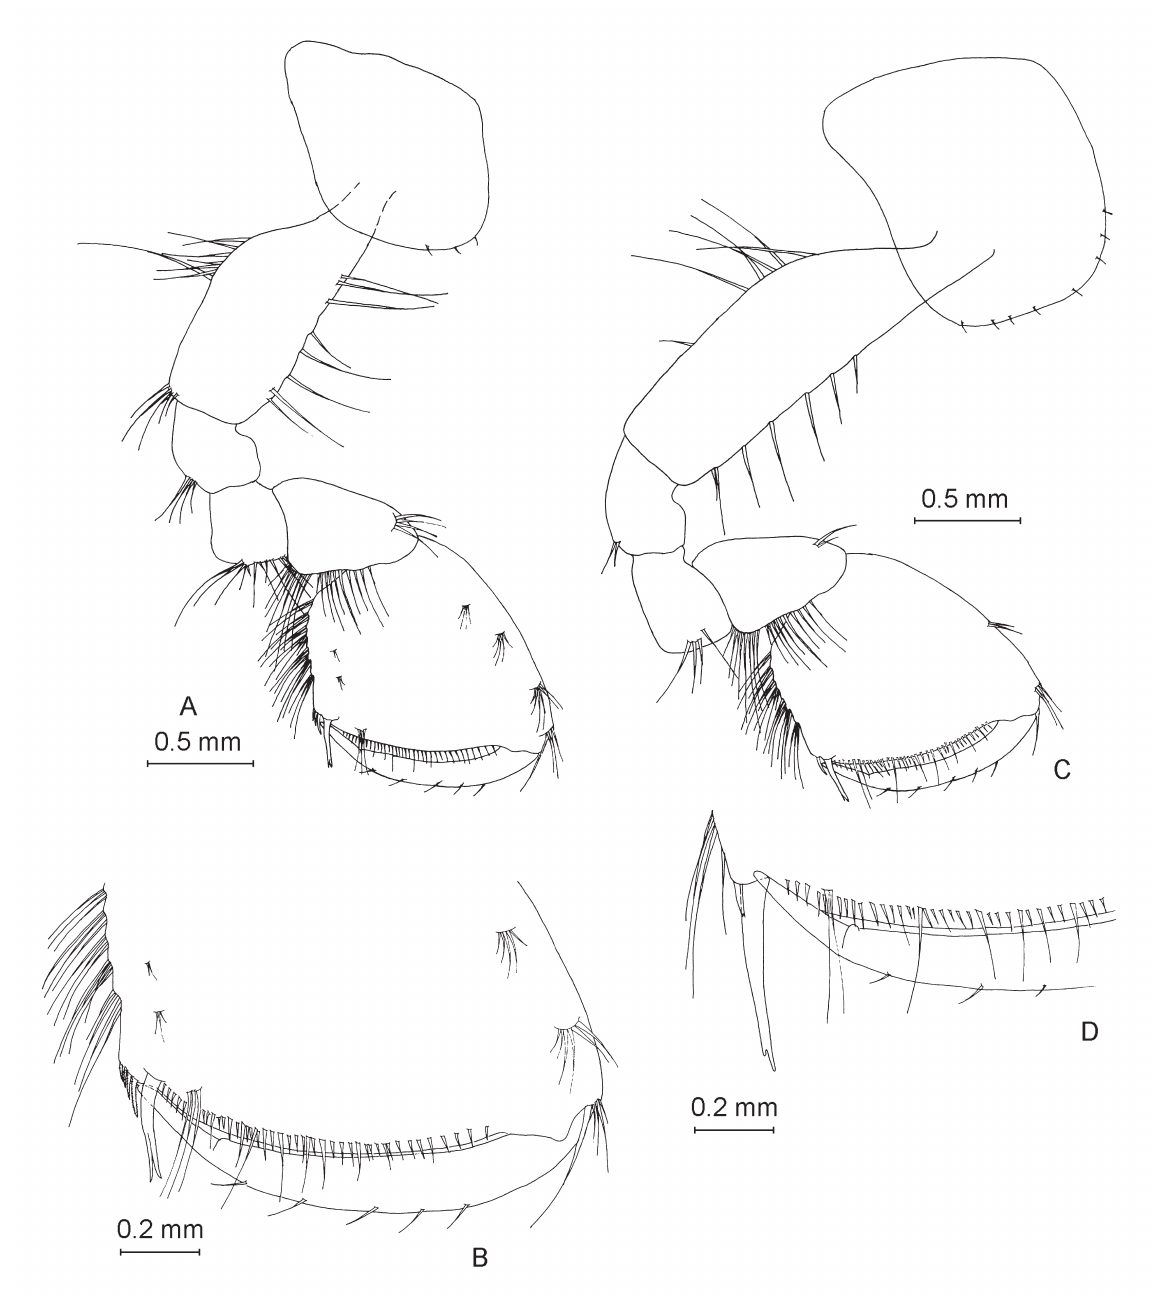
Fig. 5. ♂. A . Gnathopod I. B . Propodus of gnathopod I. C . Gnathopod II. D . Propodus of gnathopod